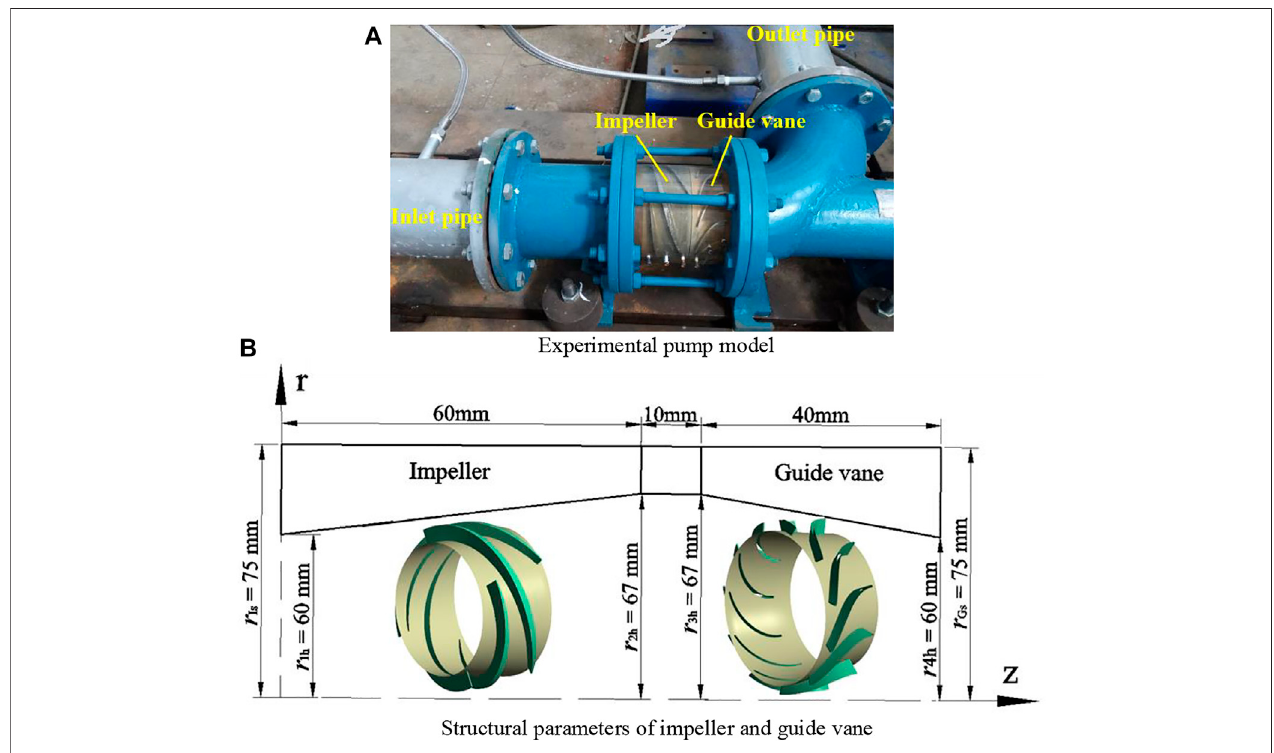
FIGURE 1 | Gas – liquid rotodynamic pump model and structural parameters. (A) Experimental pump model. (B) Structural parameters of impeller and guide vane.